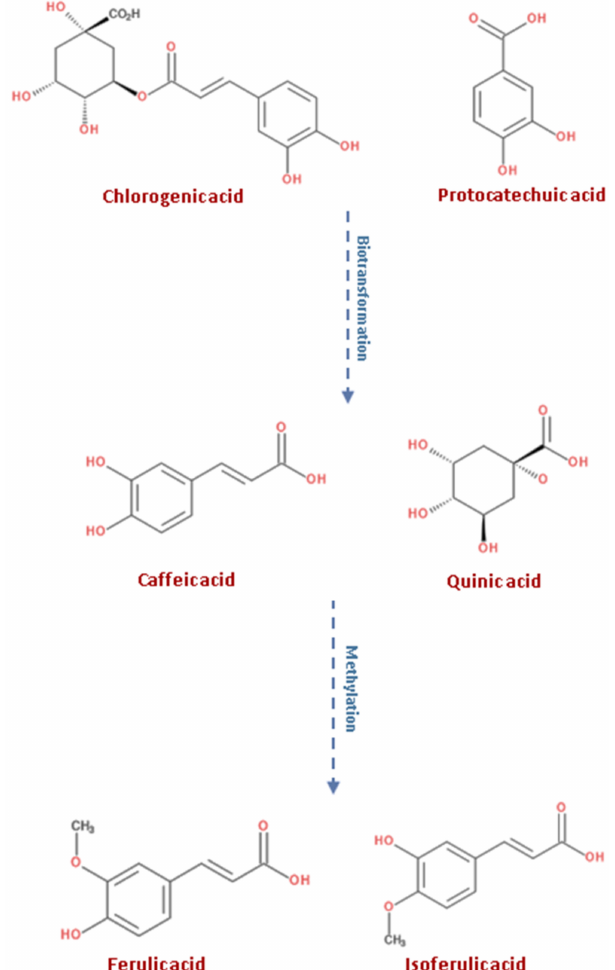
Figure 4. Biotransformation of the main phenolic acids in fruit, namely, chlorogenic and protocate- chuic acids, according to the study of Gonthier et al.